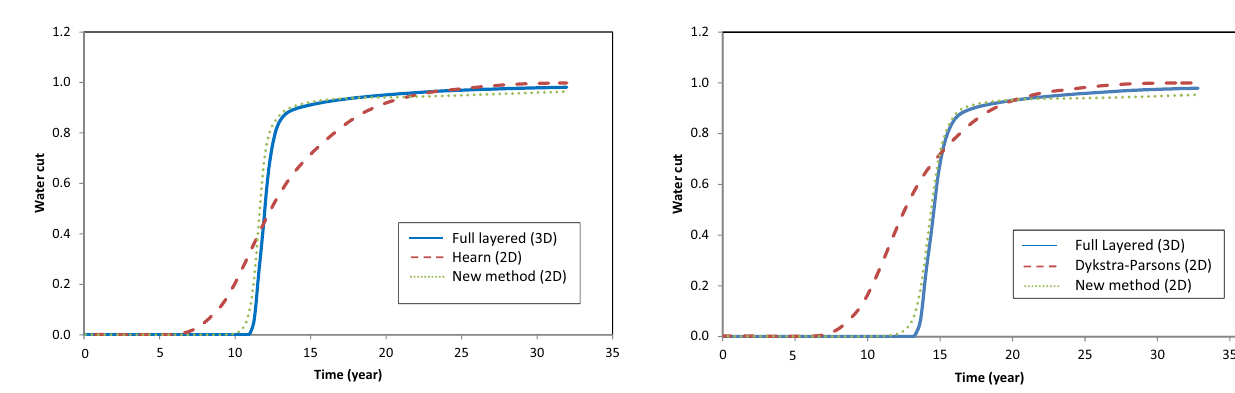
Fig. 11 Water cut comparison for constant pressure boundaries